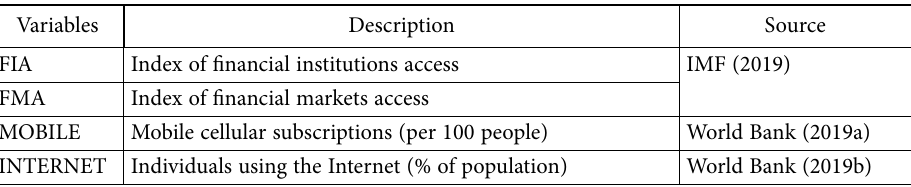
Table 1. Data description